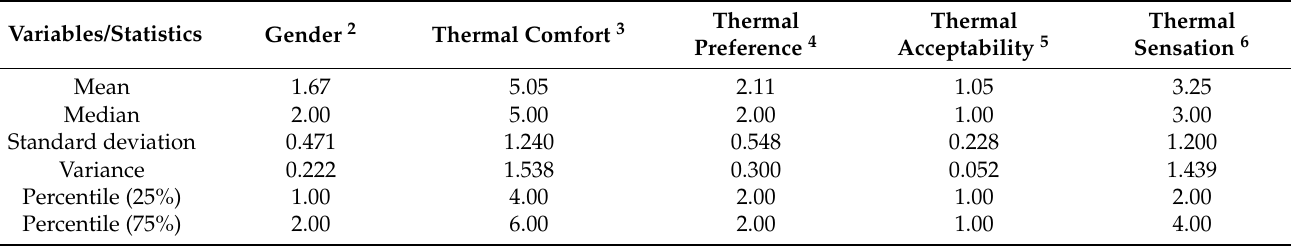
Table 1. Summary of the mean, standard deviation, variance of gender, thermal sensation, thermal acceptability, comfort, and preference in the case study buildings 1 (N = 110) *.